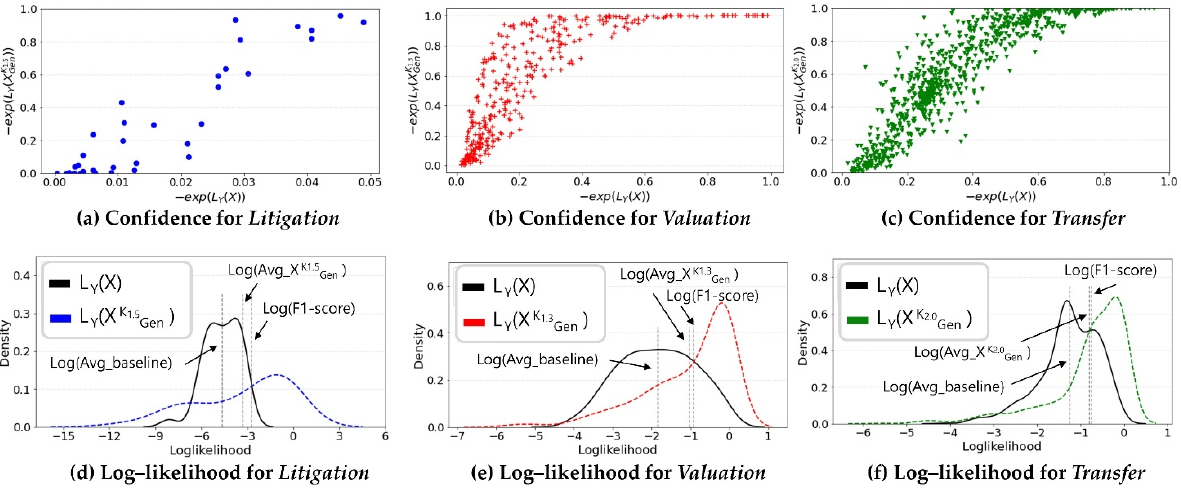
Figure 3. Results of comparing the confidence of the baseline and proposed methodology (when the generative model was C-VAE and the predictors were quantitative indicators and document texts). ( a ) As a result, the proposed method calibrated the confidence better than the baseline; ( b ) the proposed method calibrated the confidence better than the baseline; ( c ) the proposed method calibrated the confidence of transferred patents better than the baseline; ( d ) the difference between the mean of the confidence and the accuracy was smaller for the proposed method than the baseline;